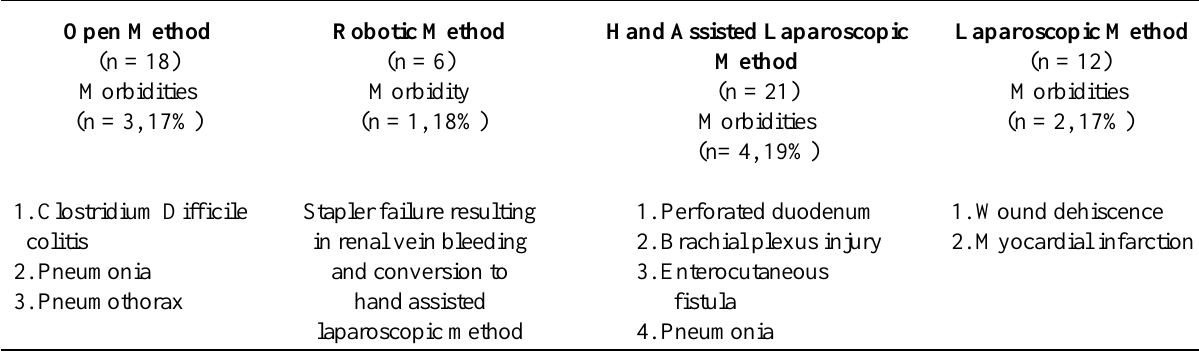
Table 3 – Morbidities following radical nephrectomy by method of